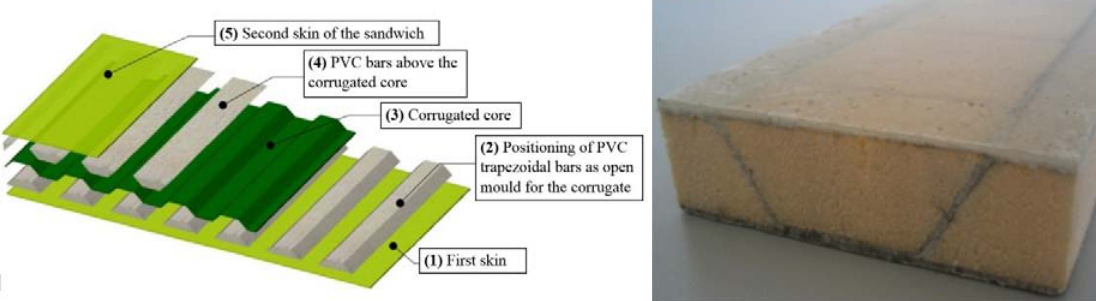
Figure 4: A sketch of the manufacturing process of the sandwich (left), a picture of a sandwich beam